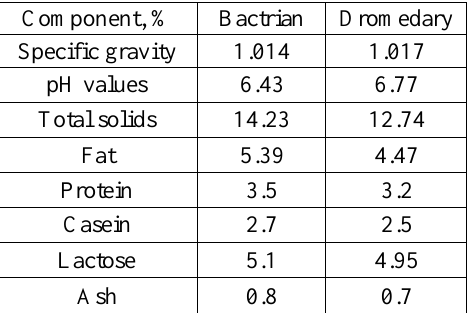
Table 1. Physical-chemical characterizations of camel